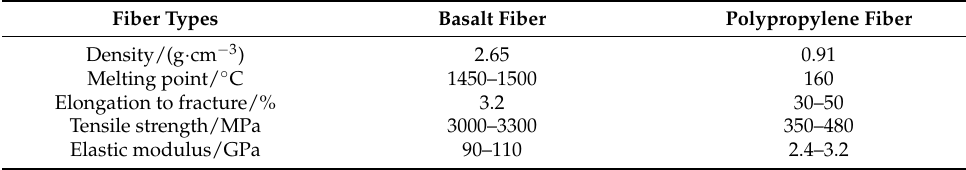
Table 2. Physical and mechanical properties of fibers [37].